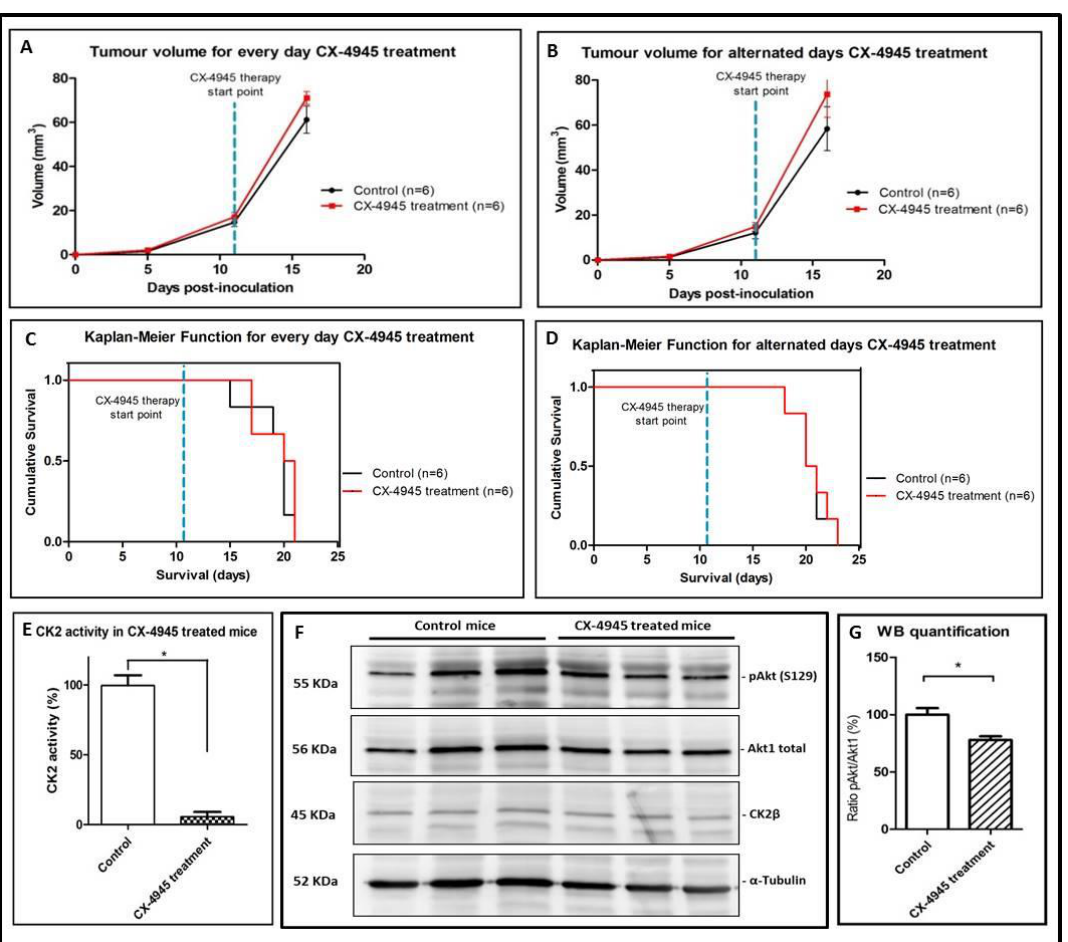
Figure 4. Tumour volumes, survival rates and CK2 activity and expression in CX-4945 treated mice. Tumour volumes (recorded at days 5, 11 and 16 p.i.) of treated ( n = 6, black line) and control non-treated bearing tumour mice ( n = 6, red line) for ( A ) CX-4945 treated every day GL261 implanted mice and ( B ) CX-4945 treated alternated days GL261 implanted mice. No significant differences were observed between groups ( p > 0.05). The dashed blue line indicates the CX-4945 therapy start point; ( C ) Survival Kaplan-Meier curve for CX-4945 treated every day mice ( n = 6) and control mice ( n = 6); ( D ) Survival Kaplan-Meier curve for CX-4945 treated alternated days mice ( n = 6) and control mice ( n = 6). No significant differences were found between groups ( p > 0.05). The dashed blue line indicates the CX-4945 therapy start point; ( E ) Tumour CK2 activity (%) in mice treated with CX-4945, n = 3, compared with control mice, n = 3. (* = p < 0.05 for Student’s t -test for the comparison of control and treated groups); ( F ) Western blot for tumour total protein homogenate (40 µ g) from different mice treated with CX-4945, n = 3, compared with control mice, n = 3. p-Akt(S129), Akt1 total, CK2 α , and α -tubulin proteins were analyzed; ( G ) Quantification of Western blot for tumour total protein homogenate (40 µ g) from mice treated with CX-4945, n = 3, compared with control mice, n = 3. Ratio (%) of p-Akt (S129) content divided by Akt1 total content. * = p < 0.05 for Student’s t -test for the comparison of control and treated groups.